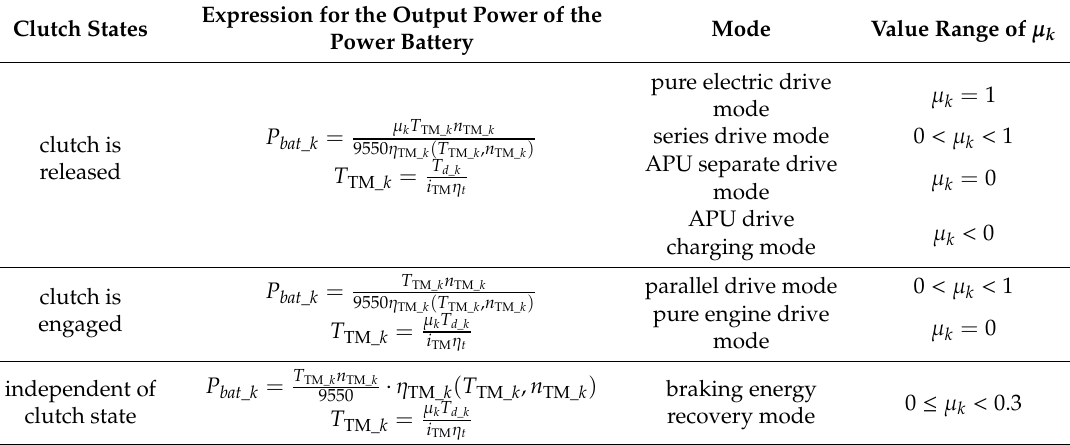
Table 2. The output power of the power battery at the di ff erent working modes. APU: auxiliary power